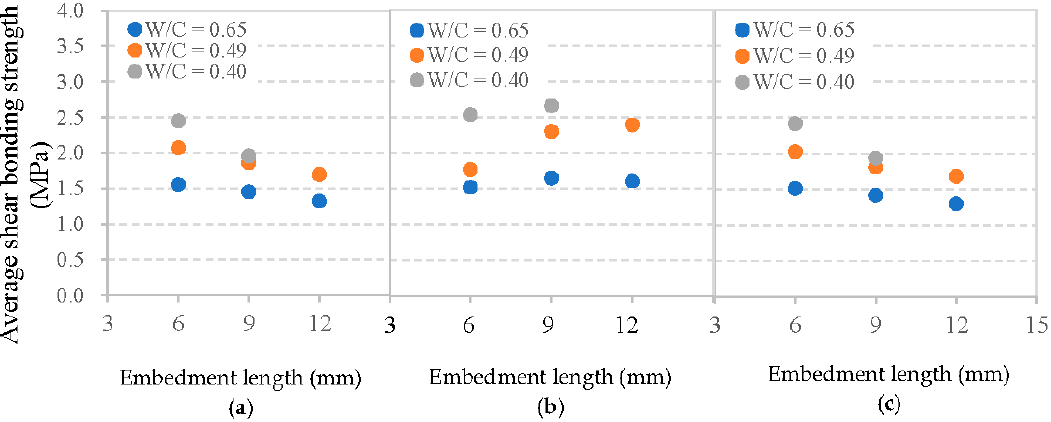
Figure 13. Average shear bonding strength between cement matrix and: ( a ) basalt fiber, ( b ) PVA fiber, and ( c ) glass fiber.